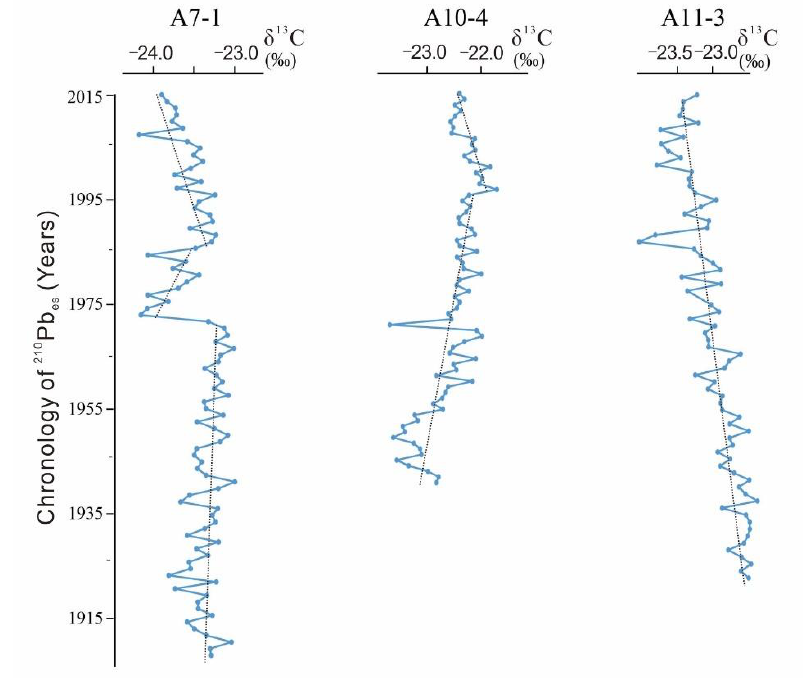
Figure 5. Results of the δ 13 C.